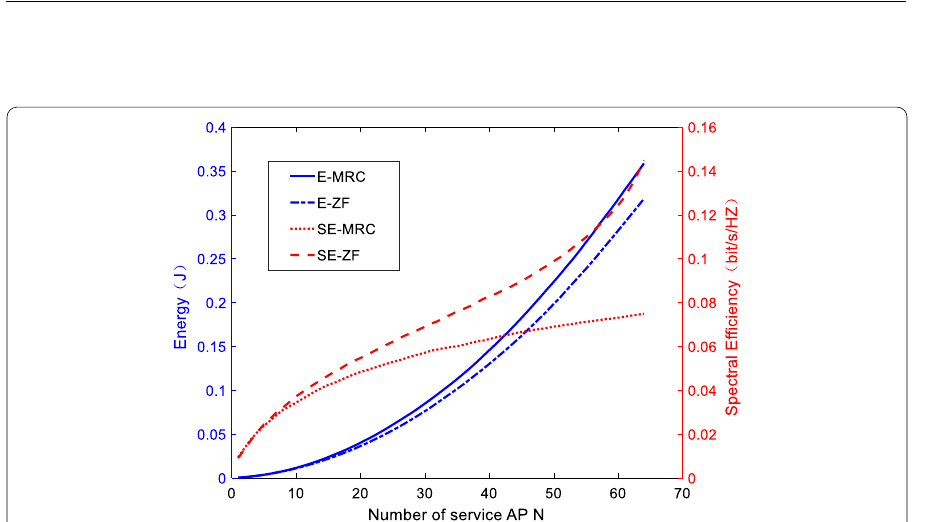
Fig. 4 Schematic diagram of the recovered energy and spectrum efficiency changing with the number of serving APs, τ e = τ d = 1 4